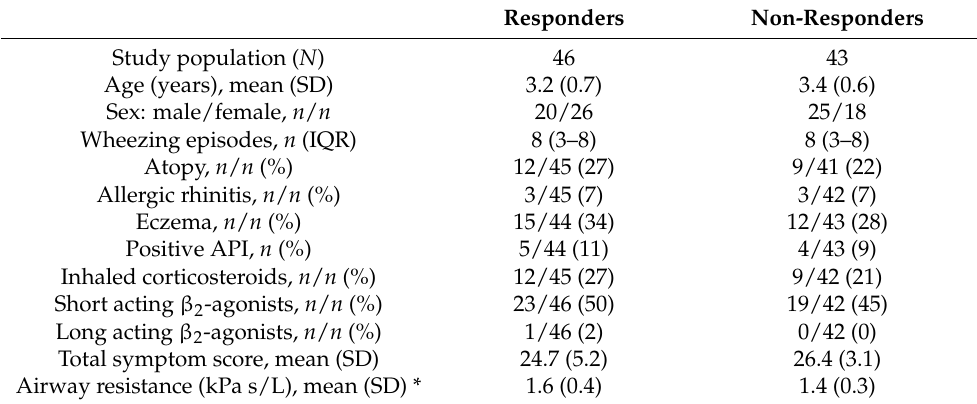
Table 1. Baseline characteristics of responders and